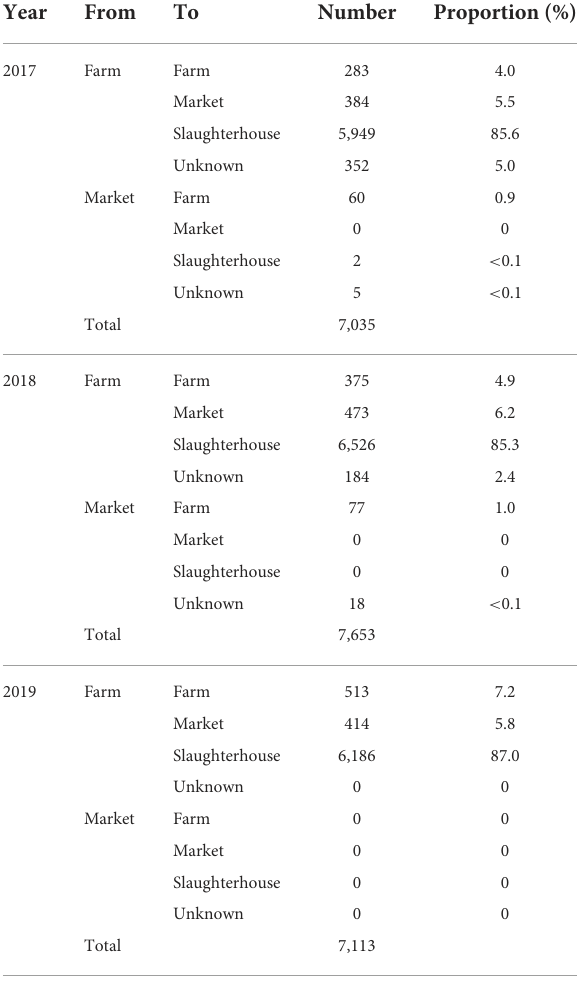
TABLE 3 Movements of live pigs in North Macedonia from 2017-2020, summarized by type of premises moving from and